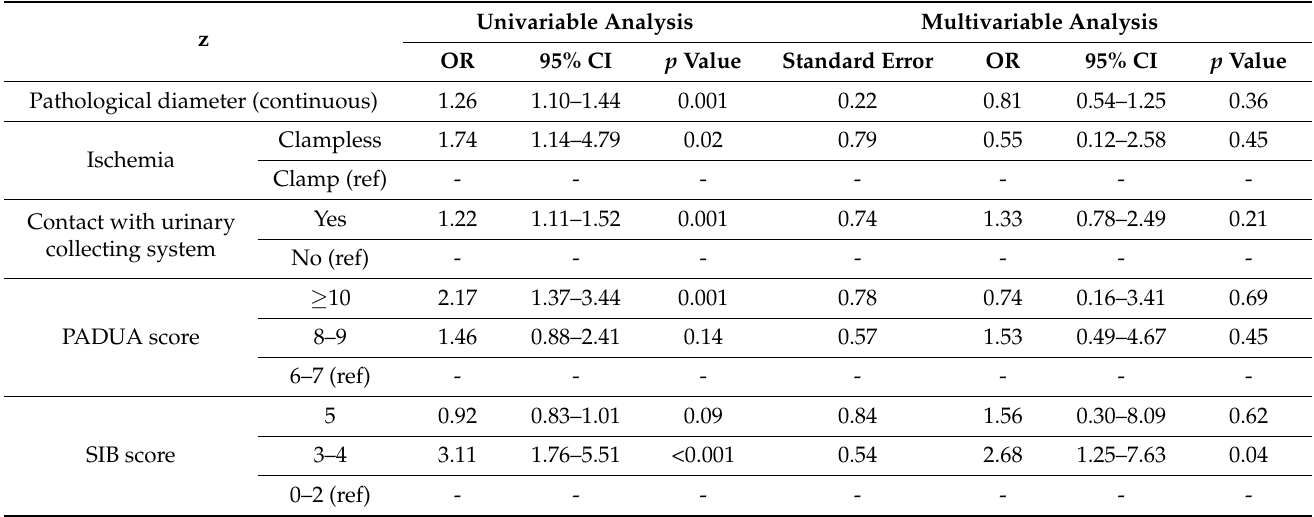
Table 4. Univariable and multivariable analysis analyzing the predictive factors for surgical predictors of